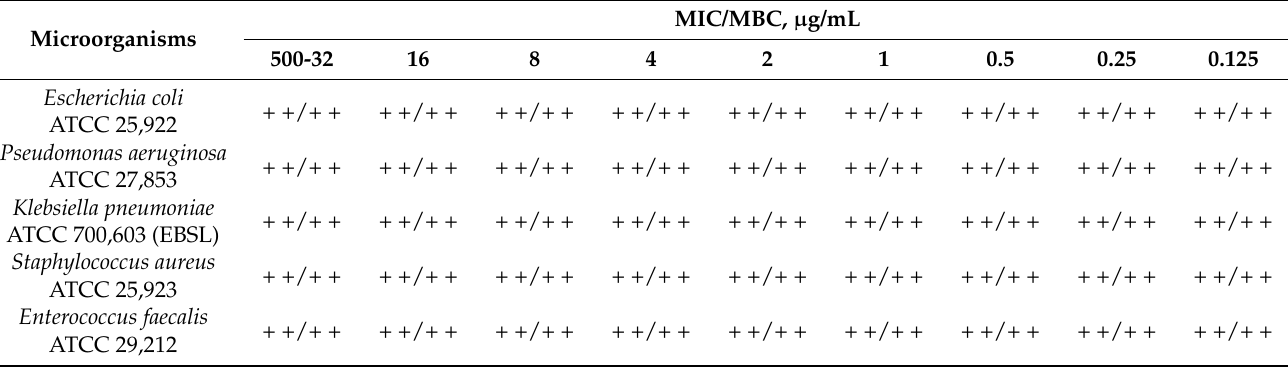
Table 2. Antimicrobial activity of poly(VT-co-Na-VSA).